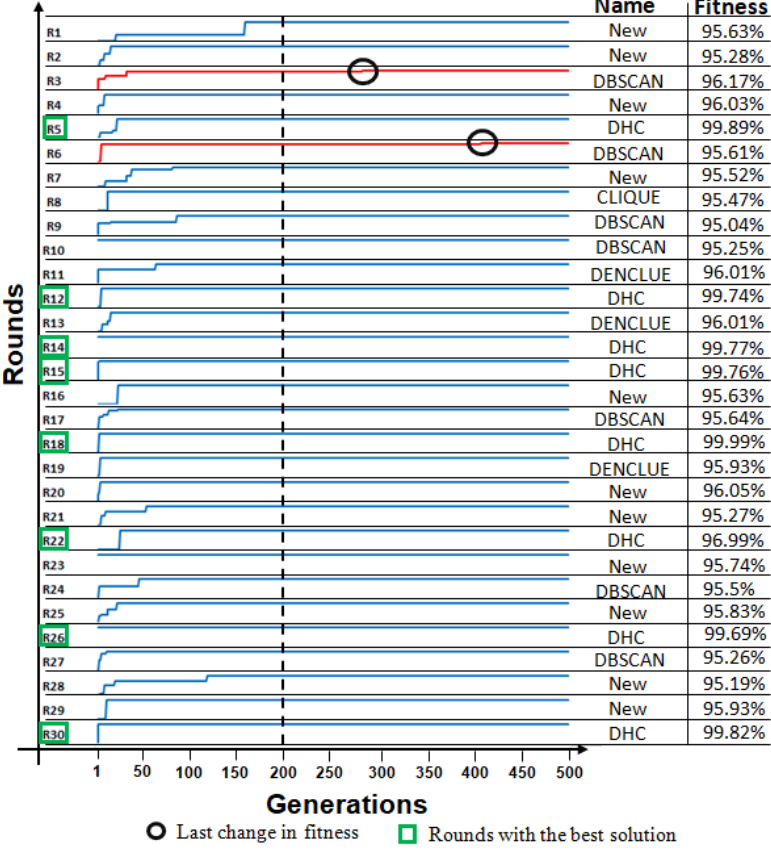
Figure 8. Line chart that shows the fitness values of the best algorithm generated over the